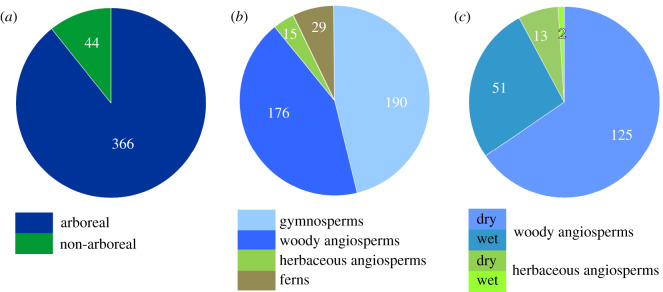
Palynomorph abundancies from sample S115992 based on 430 counted pollen and spores. Algae and unidentified angiosperm pollen excluded. (a) Ratio between pollen produced from arboreal and non-arboreal taxa. (b) Abundancies of woody gymnosperms and angiosperms and of herbaceous angiosperms and ferns. (c) Abundancy of woody and herbaceous angiosperms on dry and wet soils.